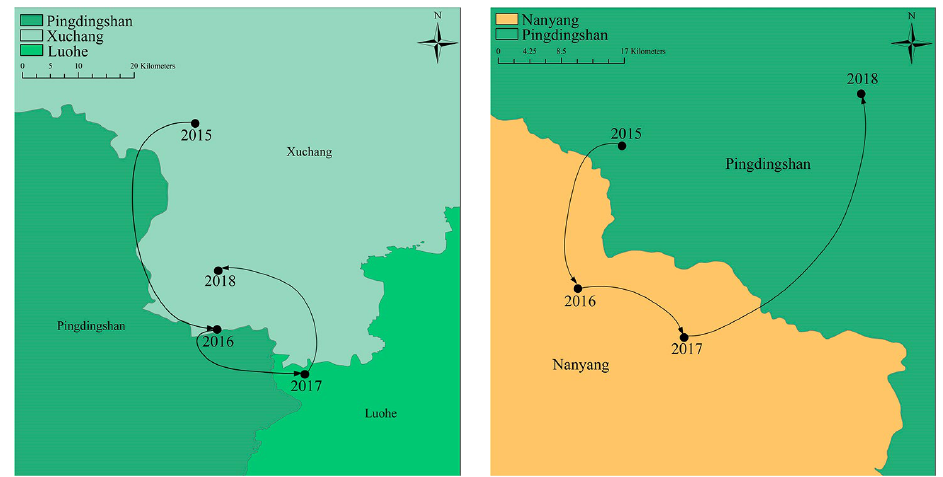
Figure 7. Migration path of gravity-center position for 30 provinces from 2015 to